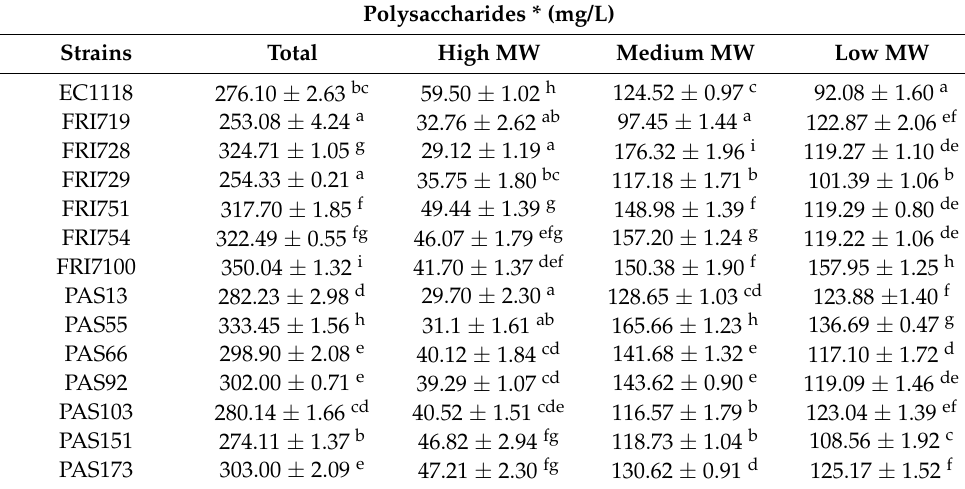
Table 6. Total polysaccharides and their fractions by SEC-HPLC in Manzoni bianco